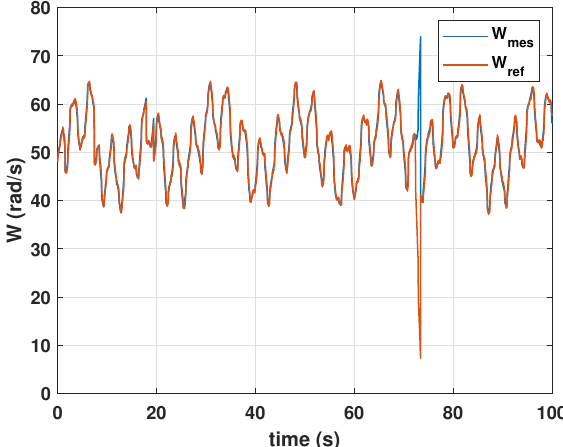
Figure 17. Angular speed variation.